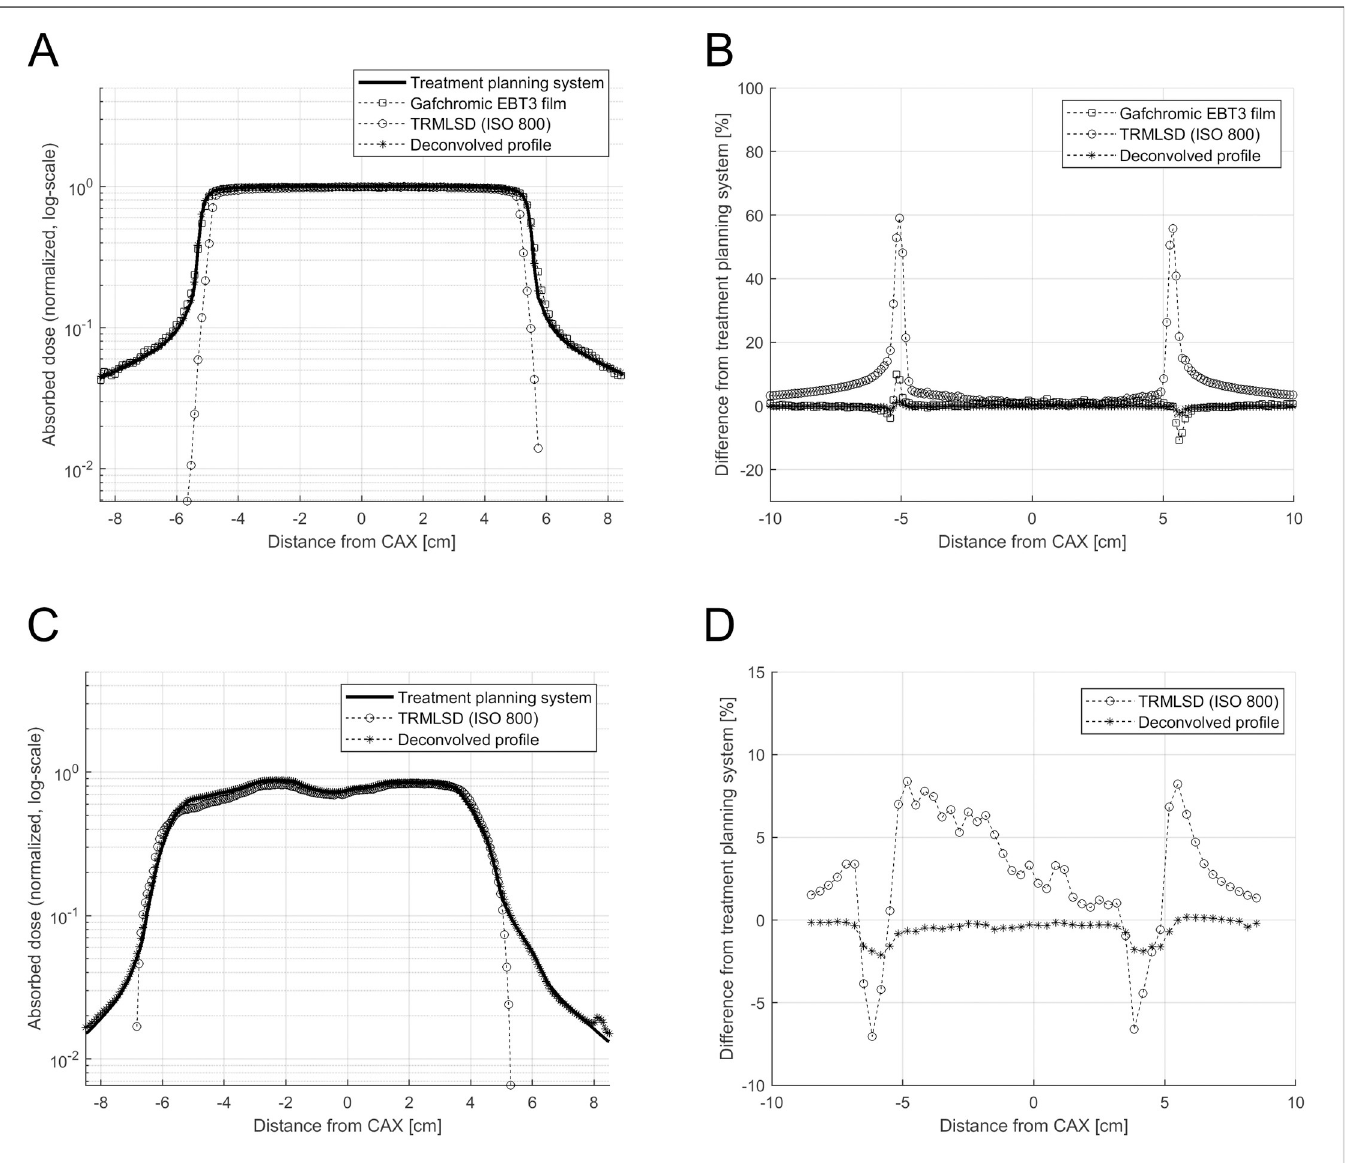
Fig 11. (A) Profiles of the 2D dose distribution for 10.0 × 10.0 cm 2 open field, (B) Dose differences of the measurements of the 10.0 × 10.0 cm 2 field with the corrected dose D (x, y), (C) Profiles of the 2D dose distribution for the IMRT plan. (D) Dose differences of measurements of IMRT plan and corrected dose D (x, y): calculated dose distribution corresponding to the TPS (denoted by the solid line), measured dose distribution corresponding to the EBT3 film (denoted by the squares), TRMLSD (denoted by the circles), and correction using PenumbraNet (deconvolved profile, denoted by the stars). https://doi.org/10.1371/journal.pone.0246742.g011 cGy, respectively (Fig 12B). The dose rate dependency was tested for 100, 300, and 400 MU/min by delivering 200 cGy. The mean and standard deviation of each dose rate for three measure- ments were 200.55 ± 0.48 cGy, 199.87 ± 0.39 cGy, 199.96 ± 0.93 cGy, respectively (Fig 12C). Percent depth dose The measurement data for the ionization chamber were normalized to the dose at the maxi- mum dose depth (12.3 mm). The TRMLSD measurements were matched to the percentage at